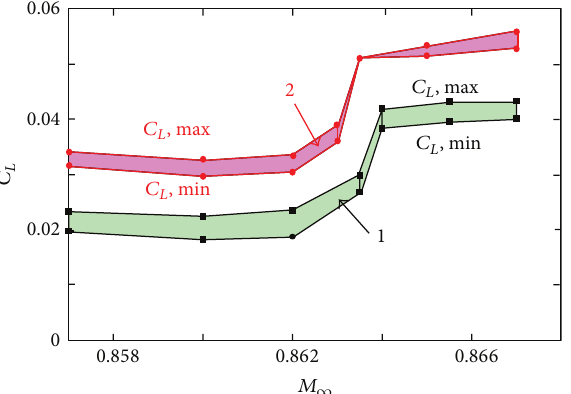
Figure 6: Lift coefficient versus 𝑀 ∞ for the unswept wing at 𝛼 = − 0.6deg: 1—Re = 5.2 × 10 6 , 2—Re = 10.4 × 10 6